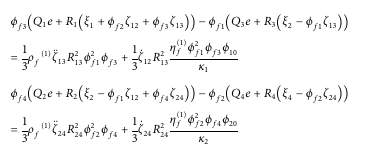
where u , U ( 1 ) , U ( 2 ) , U ( 3 ) , U ( 4 ) denote the average displacements of the frame, fl uid phase 1 (host fl uid in the